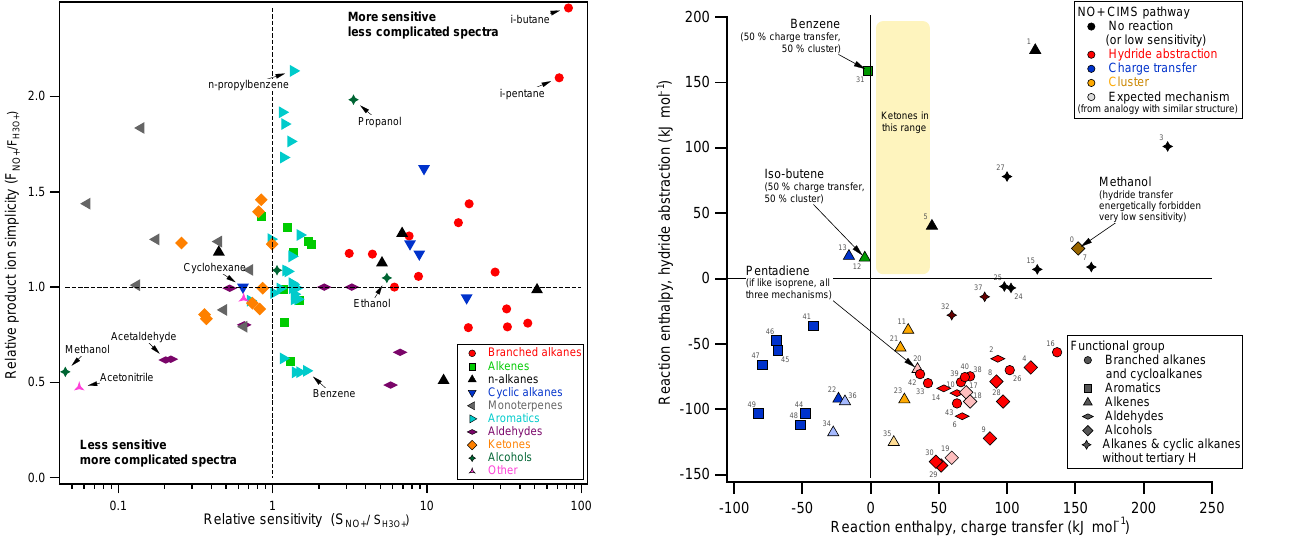
Figure 4. VOC–NO + reaction mechanism dependence on charge transfer and hydride transfer reaction enthalpy. VOC identification is indicated by the small numbers and is listed in Table 1. Hydride abstraction enthalpies for ketones are not known but can be assumed to be positive based on structural considerations (lack of tertiary hydrogen). Ion thermodynamic information is available for several species whose reaction mechanism was not experimentally verified in this or previous work; an expected mechanism was determined by analogy with a VOC of similar structure. 17 is 1-butanol, by analogy with 1-propanol; 18 is 2-methylpropanol, by analogy with 1-propanol; 19 is 2-butanol, by analogy with 2-propanol; 20 is 1,4- pentadiene, by analogy with isoprene; 34 is 4-methyl-2-pentene, by analogy with 2-pentene; 35 is 3-methyl-1-pentene, by analogy with 1-hexene; 36 is 2,3,-dimethyl-1-butene, by analogy with